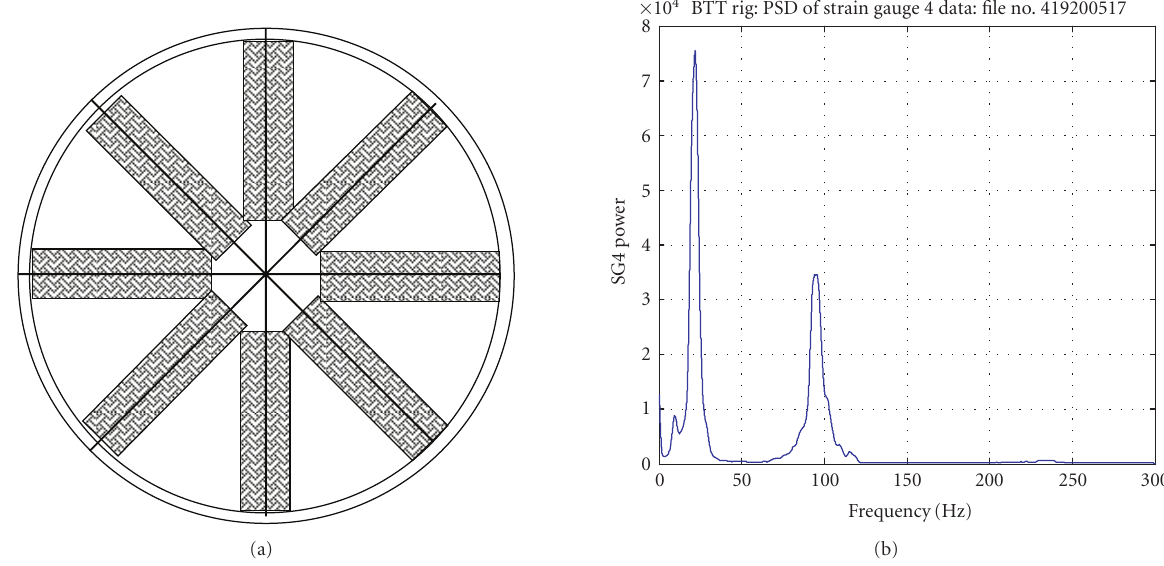
Figure 5: Eight 8EO blockers (a) and power spectral density of resulting blade response (b).